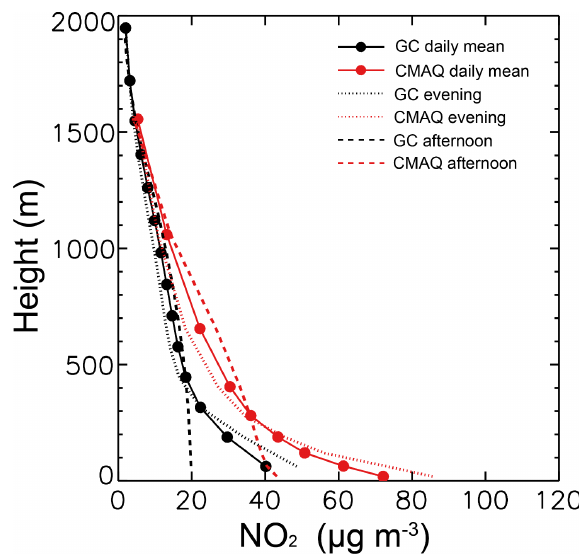
Figure 12. Eastern China mean NO 2 vertical profiles simulated by GEOS-Chem and CMAQ averaged over 25 October–25 Decem- ber 2013. The black and red dots denote the center of each verti- cal layer in the two models. The evening is from 20:00 to 23:00LT, while the afternoon is from 12:00 to